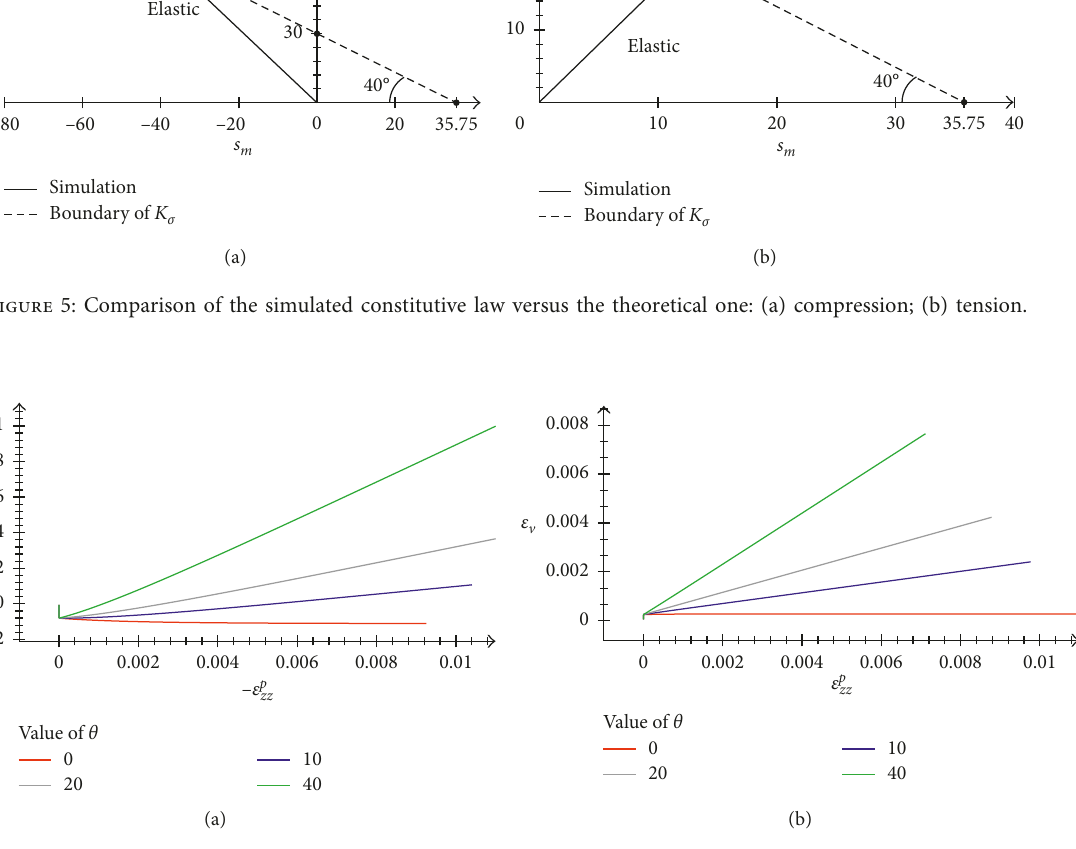
Figure 6: Volume expansion under different dilatancy angles: (a) compression; (b) tension.